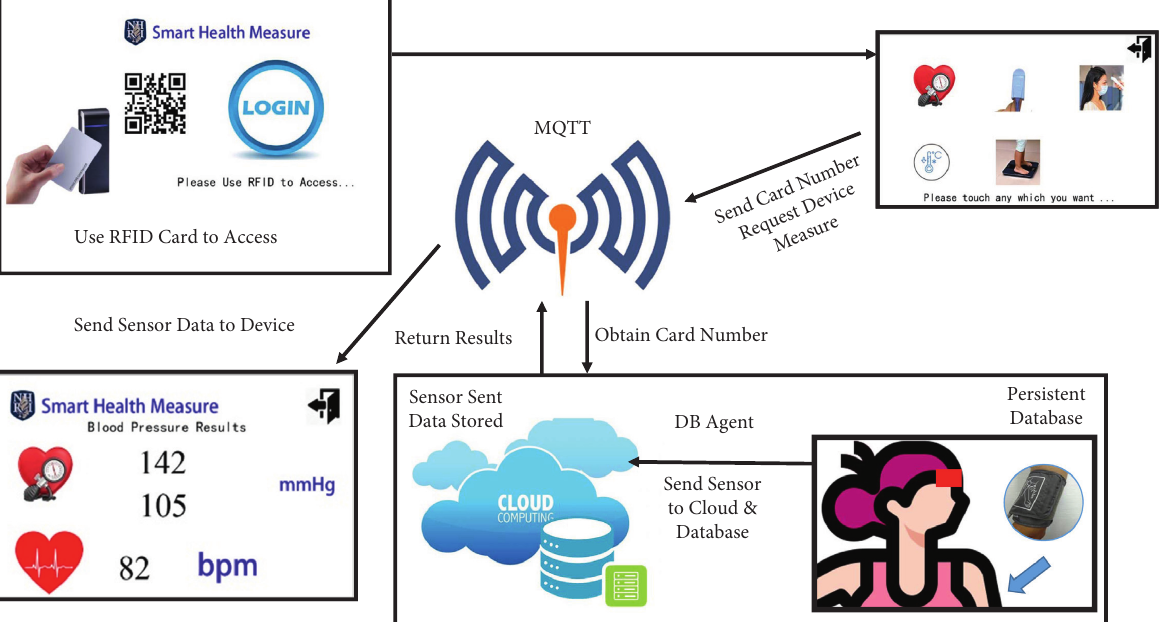
Figure 2: Workflow of the system proposed in this paper. Step 1: users use their health ID card to access the RFID controller, which can read the RFID inner ID number, and choose measurement options on a TFTscreen to select the measurement device. Step 2: the RFID controller sends a health ID card and job ID via an MQTT broker over a Wi-Fi connection to notify the selected device (head temperature, body temperature, body weight, blood oxygen, or blood pressure sensor) to be ready for use. Step 3: users use the selected device, which then sends results via the MQTT broker and cloud platform over a Wi-Fi connection. All results are instantly displayed on both the TFTtouch screen of the RFID controller and a browser running on any smartphone or desktop